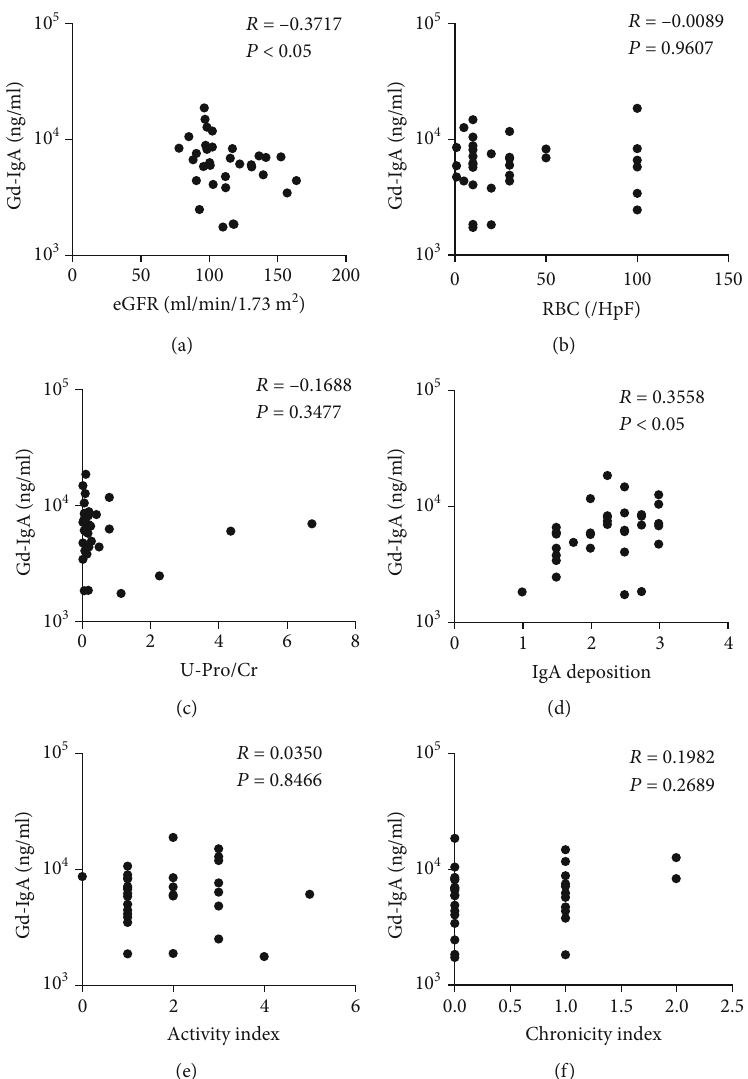
Figure 5: Correlation between serum Gd-IgA1 levels and clinical and histological parameters in patients with IgA nephropathy: (a) eGFR, (b) hematuria, (c) proteinuria, (d) mesangial IgA deposition, (e) activity index, and (f) chronicity index. RBC: red blood cells; HpF: high-power fi eld; U-Pro/Cr: urinary protein to creatinine